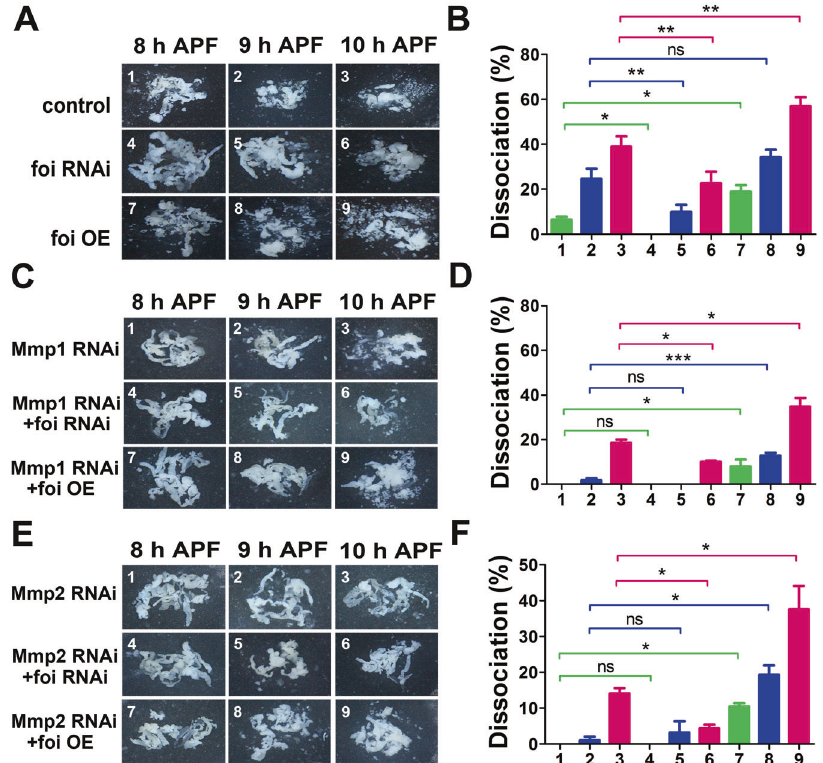
Fig. 5 Retarded fat body cell dissociation caused by Mmps knockdown could be rescued by foi OE. A , B Fat body cell dissociation was signi fi cantly delayed in Lsp2-Gal4 > foi RNAi , whereas a signi fi cant advance in fat body cell dissociation was also observed in Lsp2-Gal4 > foi OE . C , D The retarded fat body cell dissociation caused by Mmp1 RNAi could be enhanced by foi RNAi while rescued by foi OE . E , F foi RNAi aggravated the retarded fat body cell dissociation caused by Mmp2 RNAi, while foi OE rescued it. All the experiments were conducted independently at least for 3 times. ns: not signi fi cant, * P < 0.05, ** P < 0.01, *** P < 0.001, two-tailed Student ’ s t